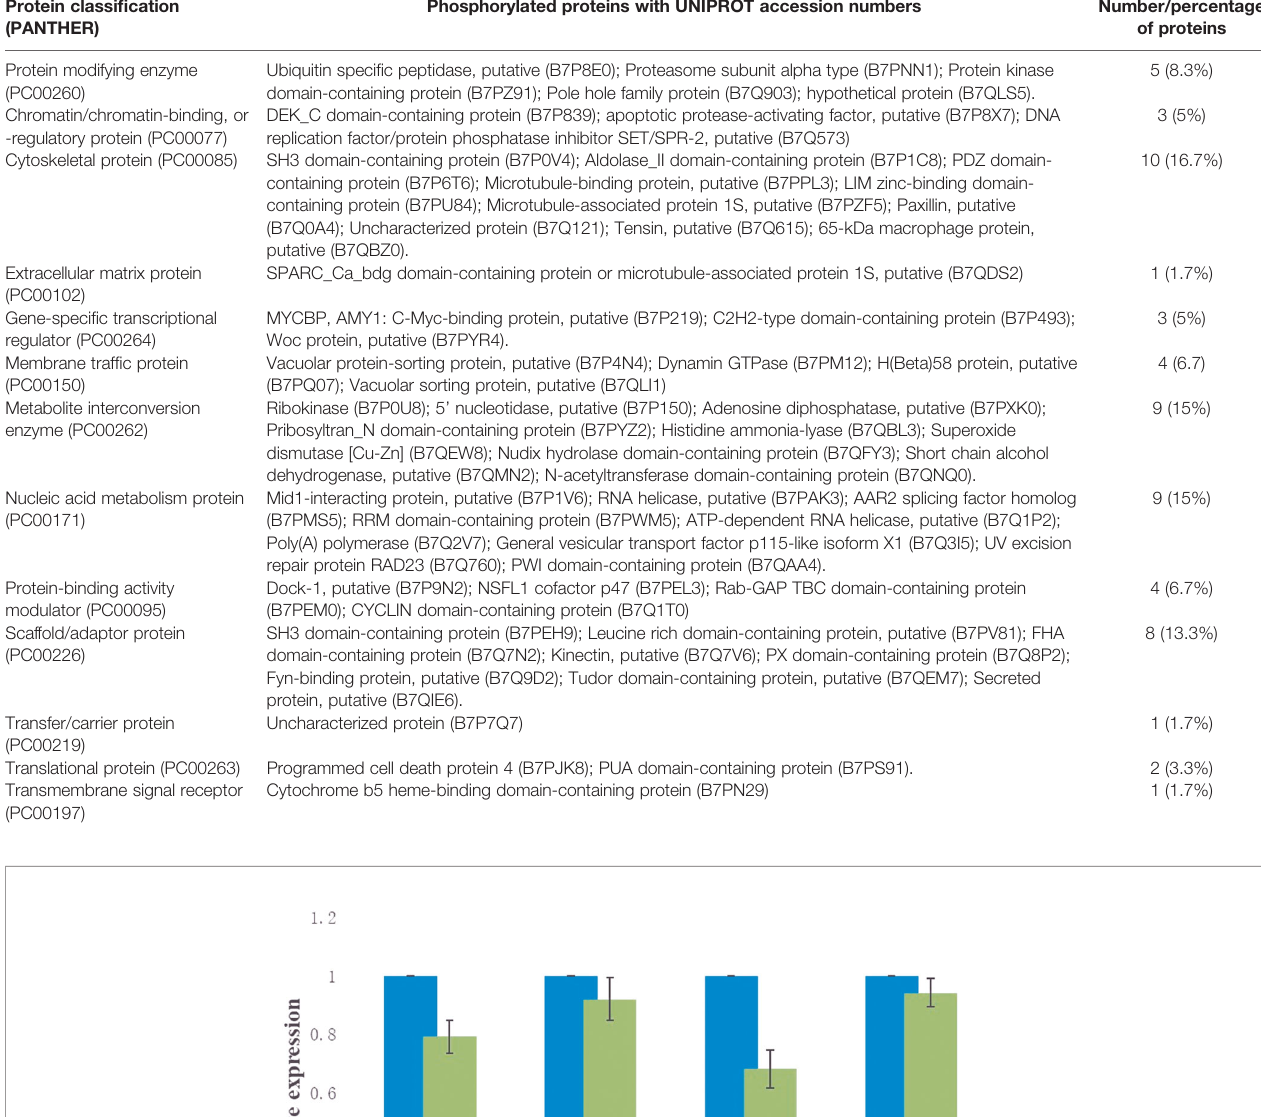
TABLE 1 | Categorization of the phosphorylated saliva proteins of Haemaphysalis longicornis ticks according to PANTHER protein classi fi cation. Protein classi fi cation (PANTHER)